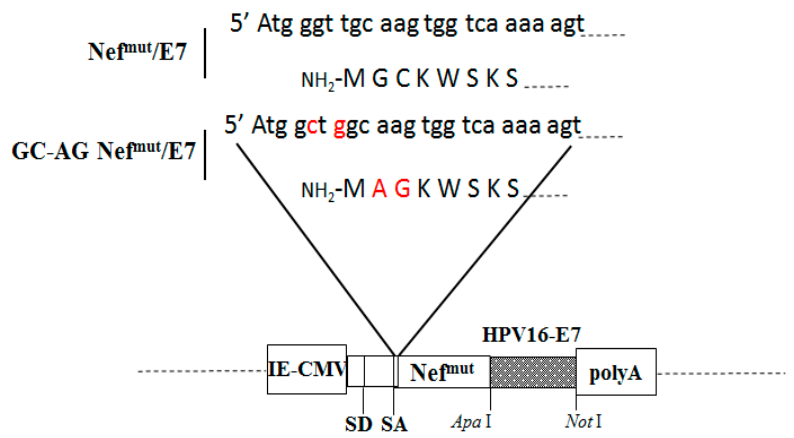
Figure 1. Structure of the DNA molecular constructs expressing Nef mut -based products. On the top, shown are both nucleotide and amino acid N-terminal sequences of both Nef mut / E7 and GC-AG Nef mut / E7. Mutated sequences of the latter are highlighted in red. At the bottom, the structure of both DNA vectors is reported, including the restriction sites where the HPV16-E7 open reading frame was inserted. IE-CMV: immediate-early CMV promoter; SD: major splice donor site; SA major splice acceptor site; polyA: polyadenylation site.